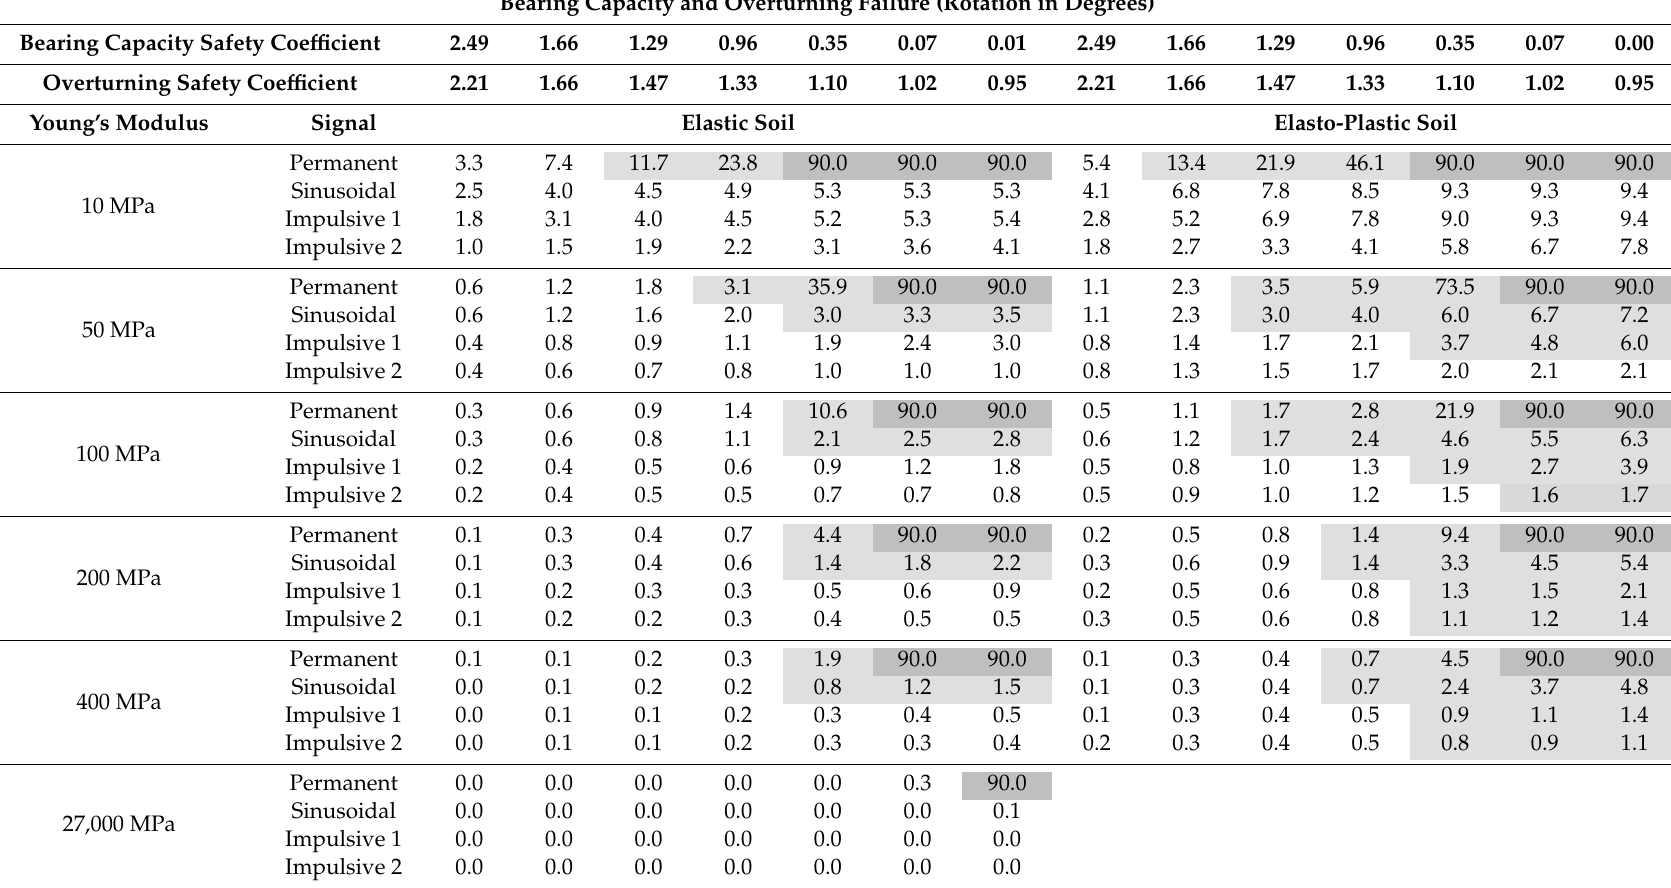
Table 9. Crown wall turning in simulations under load state C. [The simulations with failure of the structure are highlighted in dark gray (failure due to rigid overturning) and in light gray (failure due to bearing capacity of the foundation)].